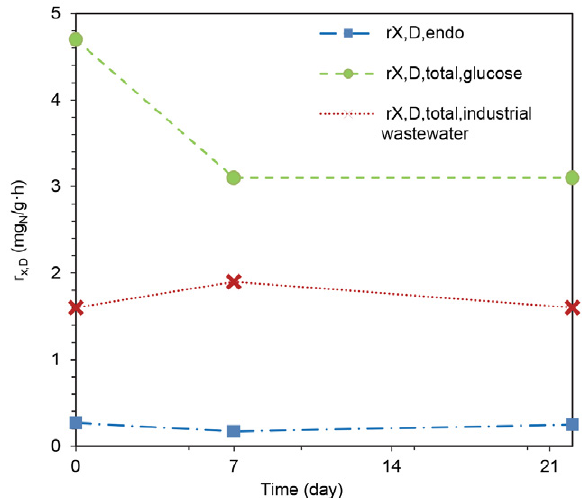
Figure 1. Rates of endogenous denitrification r X,D,endo (test D 1 ), to- tal denitrification r X,D,total,glucose with glucose as organic substrate (test D 2 ), and total denitrification r X,D,total,industrial wastewater with in- dustrial wastewater as organic substrate (test D 3 ).